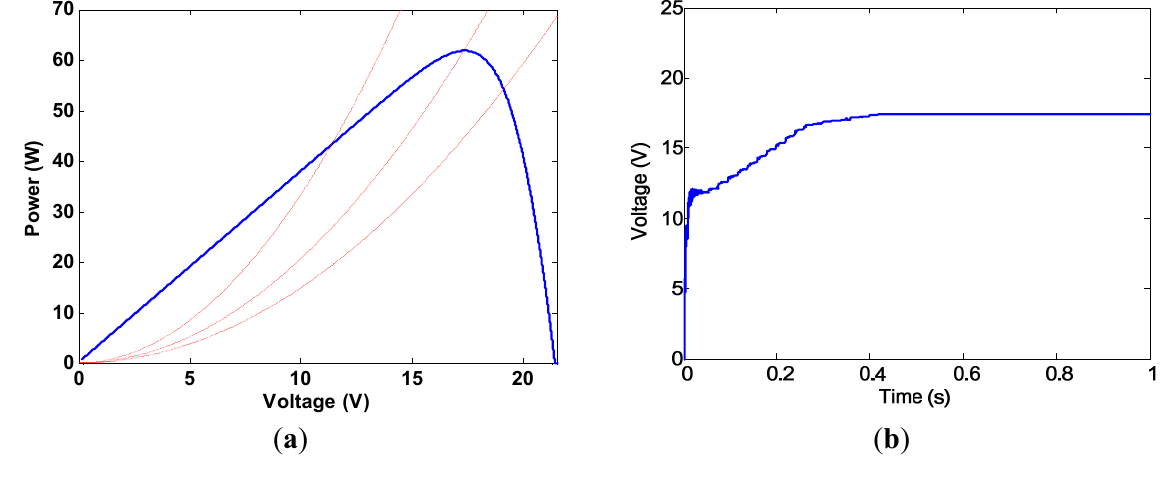
Figure 14. Circuit simulation results with 3  load. ( a ) Power characteristics; ( b ) Duty ratio command; ( c ) Output voltage from PV model; ( d ) Output current from PV